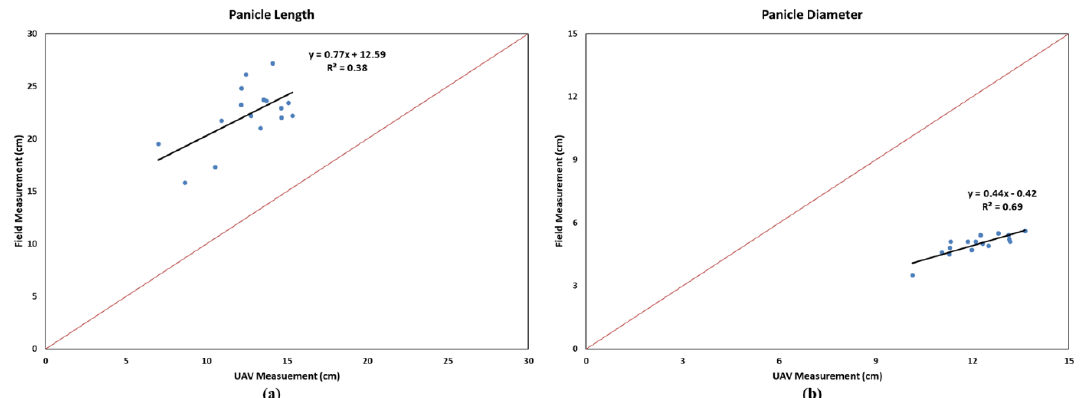
Figure 5. Relationships between field and UAV-based measurements of average panicle ( a ) length and ( b ) diameter in the selected varieties. The red line indicates the 1-to-1 line.